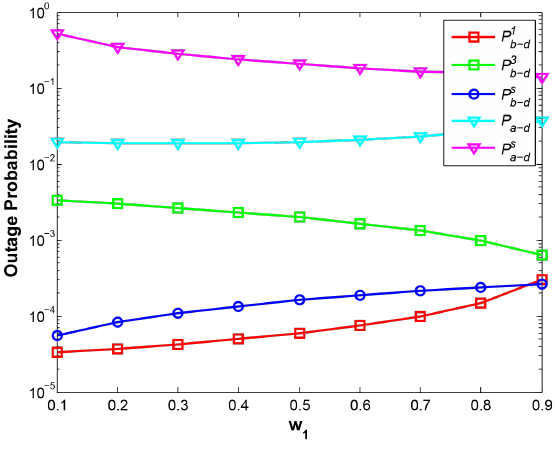
Figure 3. OP vs. w 1 at d 1 = 3.